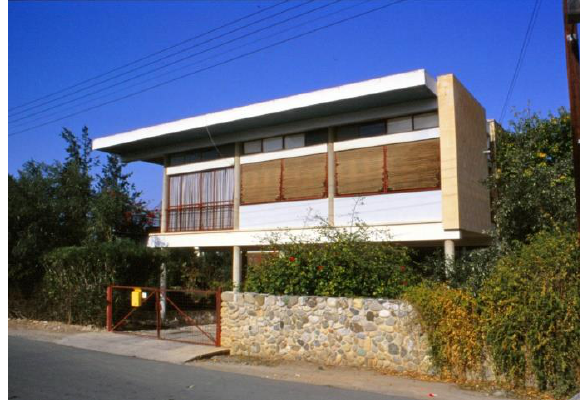
Figure 17. Theotodos Kanthos residence (1949-1952).